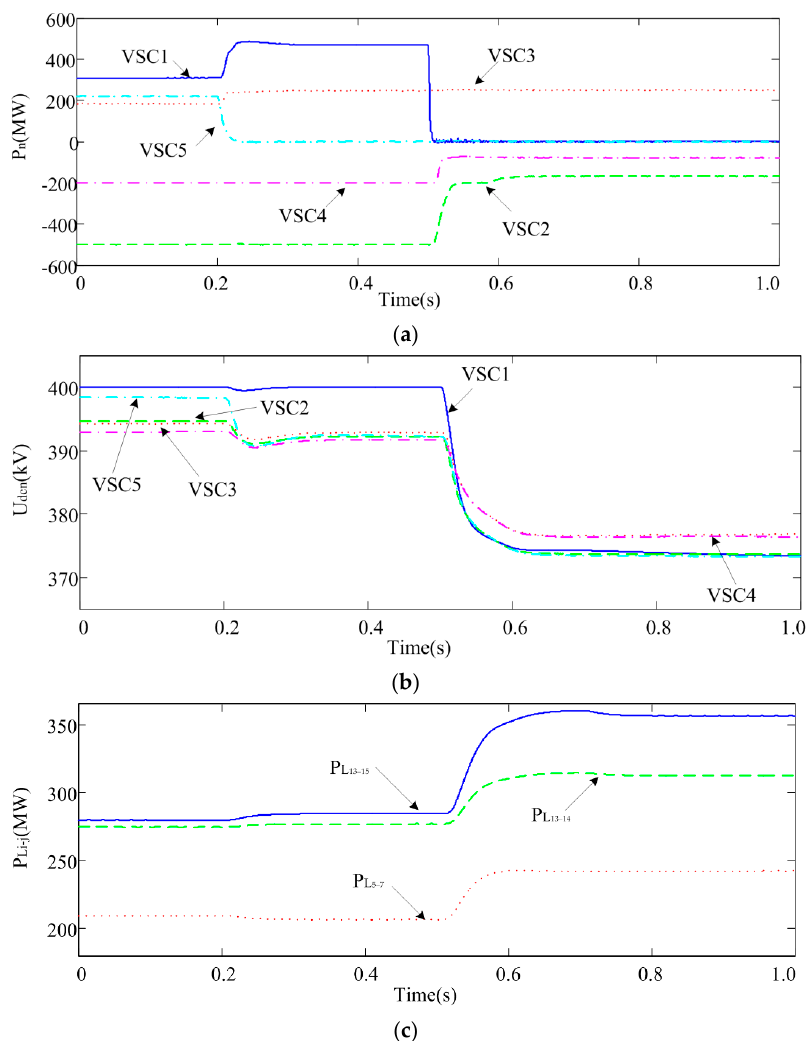
Figure 11. Simulation under the special condition of the shared control mode. ( a ) Active power of converters. ( b ) DC voltage of converters. ( c ) Active power of critical AC lines.